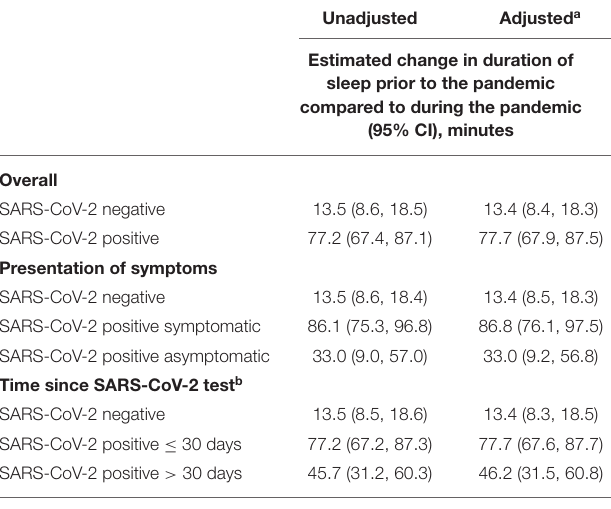
TABLE 4 | Change in sleep duration among CoVHORT study participants from pre-pandemic to during the pandemic by SARS-CoV-2 test group, presentation of symptoms, and time since SARS-CoV-2 test, n = 1,487. Unadjusted Adjusted a Estimated change in duration of sleep prior to the pandemic compared to during the pandemic (95% CI),